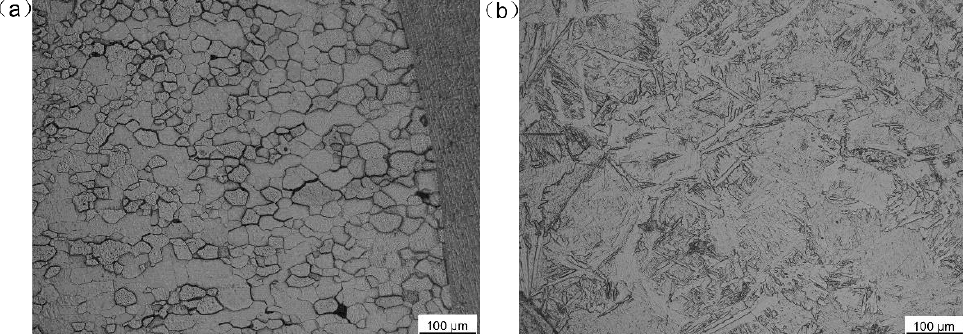
Figure 6. Microstructure of the HAZs ( a ) at molybdenum side and ( b ) at titanium side.